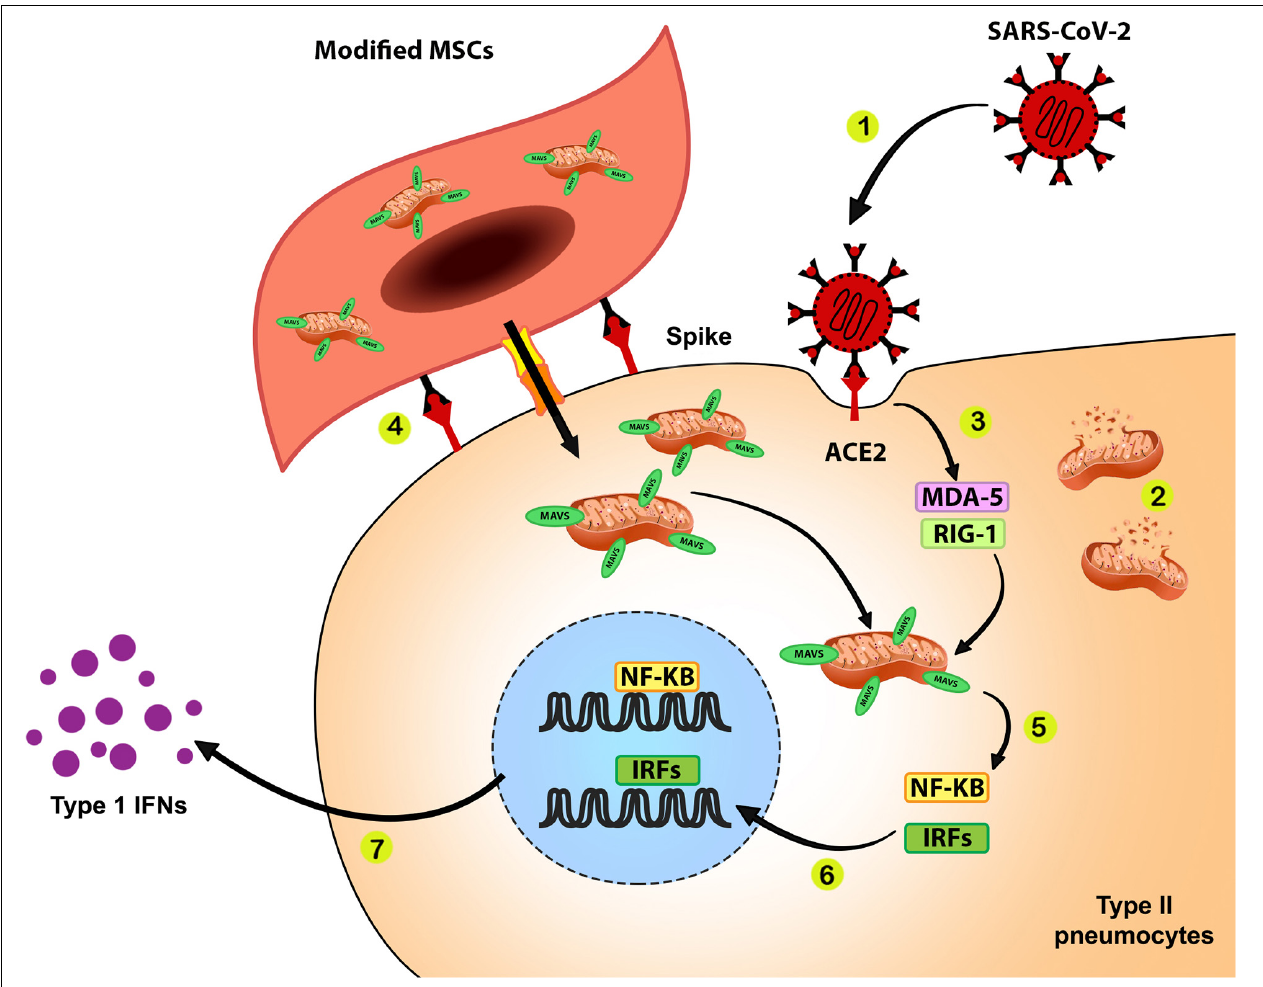
FIGURE 1 | Improving anti-SARS-CoV-2 response during mitochondrial therapy by donating mitochondria with over-expressed MAVS. 1. SARS-CoV-2 infects ACE2 expressing cells such as surfactant-secreting type II alveolar cells via interaction between the viral spike protein and ACE2. 2. Cell infection with SARS-CoV-2 results in mitochondrial dysfunction and disturbances of bioenergetics and innate immune response in infected cells. 3. The RNA content of SARS-CoV-2 is recognized by pattern recognition receptors such as MDA-5 and RIG-1. 4. MSCs that express surface spike protein as ACE2 ligand and containing mitochondria with overexpressed MAVS transfer these modified mitochondria to the surfactant-secreting type II alveolar cells. 5. Binding of activated MDA-5 and RIG-1 to the MAVS on the outer membrane of healthy donated mitochondria would activate NF- κ B and IRF transcription factors. 6. NF- κ B and IRF translocate into the cell nucleus and upregulate genes related to the innate immune response against SARS-CoV-2. 7. Function of NF- κ B and IRF will lead to the production of IFNs, which play a pivotal role in the antiviral